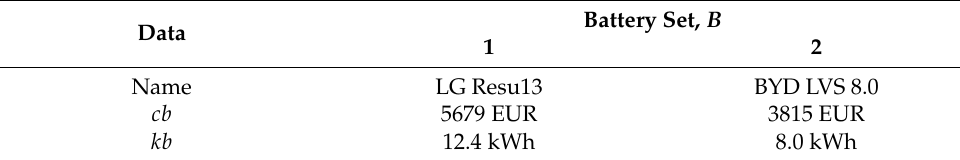
Table 4. Description of battery set: designation, unit cost, and capacity.